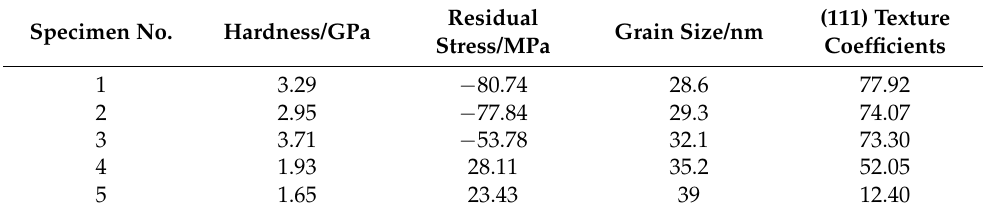
Table 2. Residual stress of Nickel coatings.